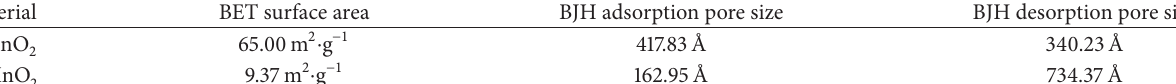
Table 1: BET and BJH analysis results of 𝛾 -MnO 2 and 𝛼 -MnO 2 .